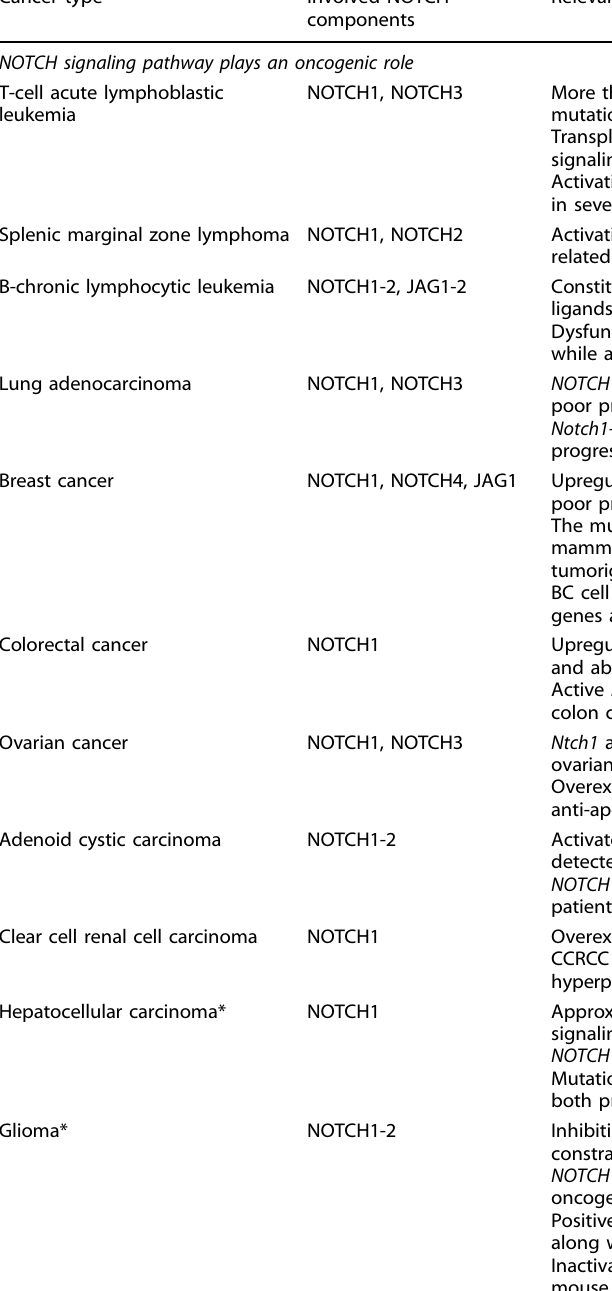
Table 2. NOTCH Signaling in Cancers Cancer